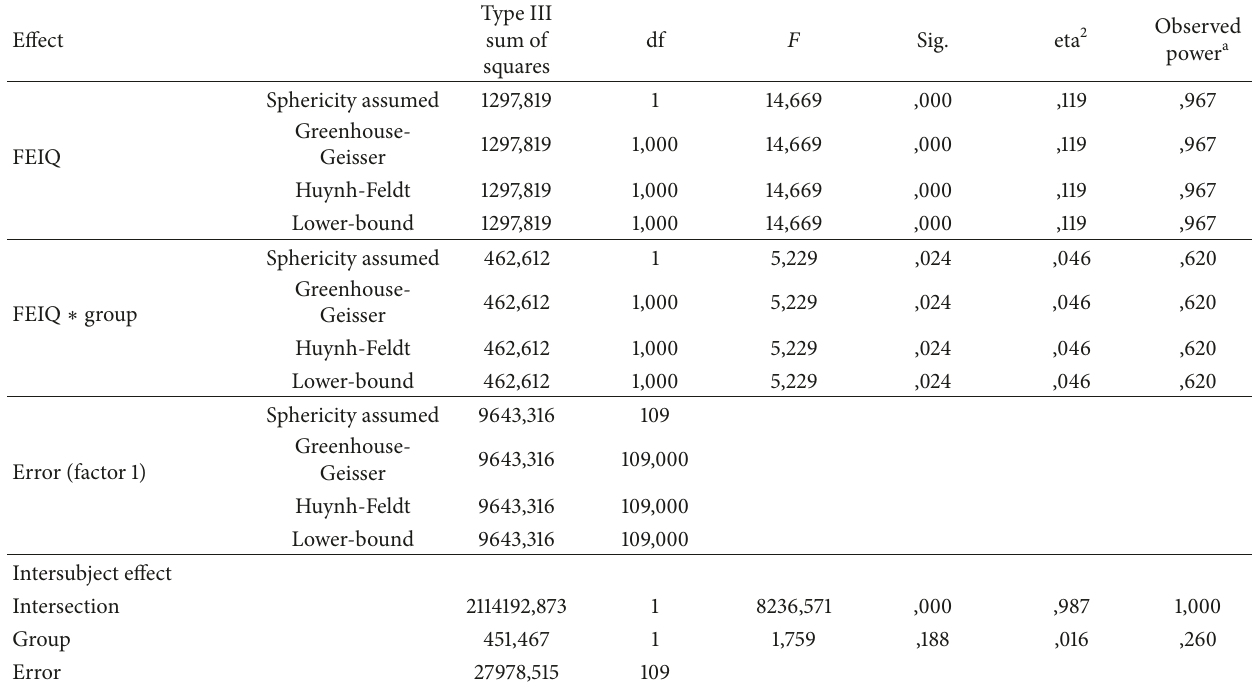
Table 5: FEIQ intrasubject and intersubject